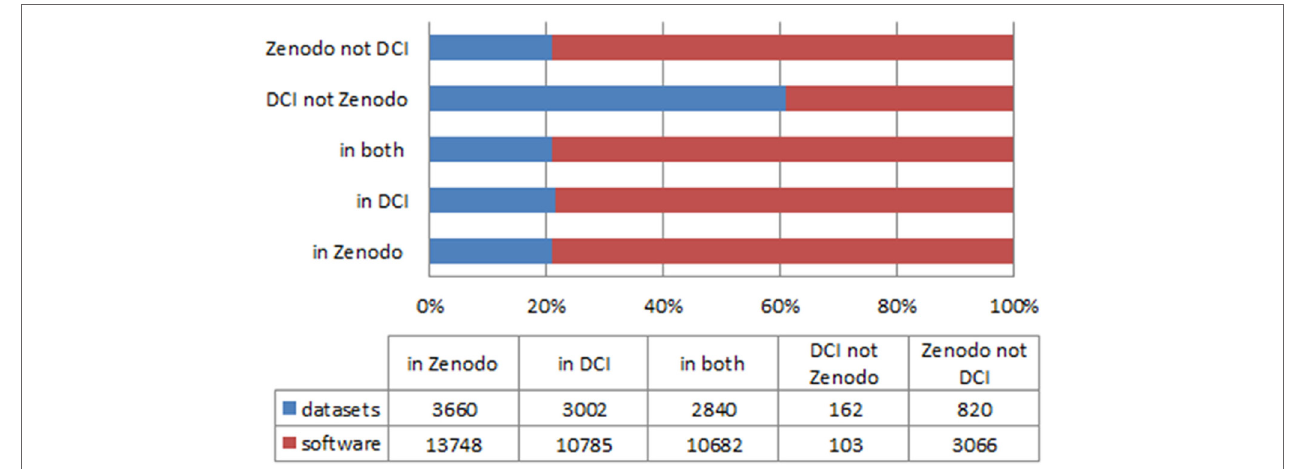
FigUre 2 | Coverage of Zenodo data records in the Data Citation Index (DCI) (Zenodo data record types: datasets and software; all publication